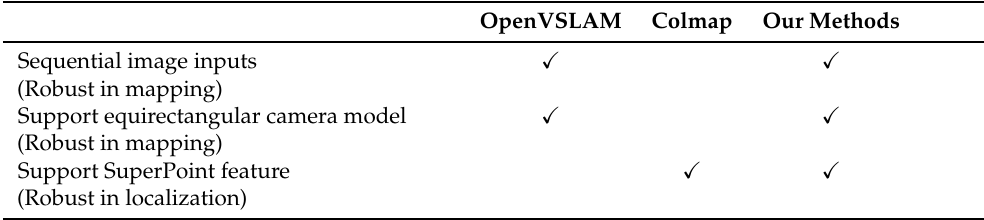
Table 1. Advantages of our methods compared with OpenVSLAM and Colmap. Our approaches use sequential image inputs and support both the equirectangular camera model and the SuperPoint feature, resulting in strong mapping and localization